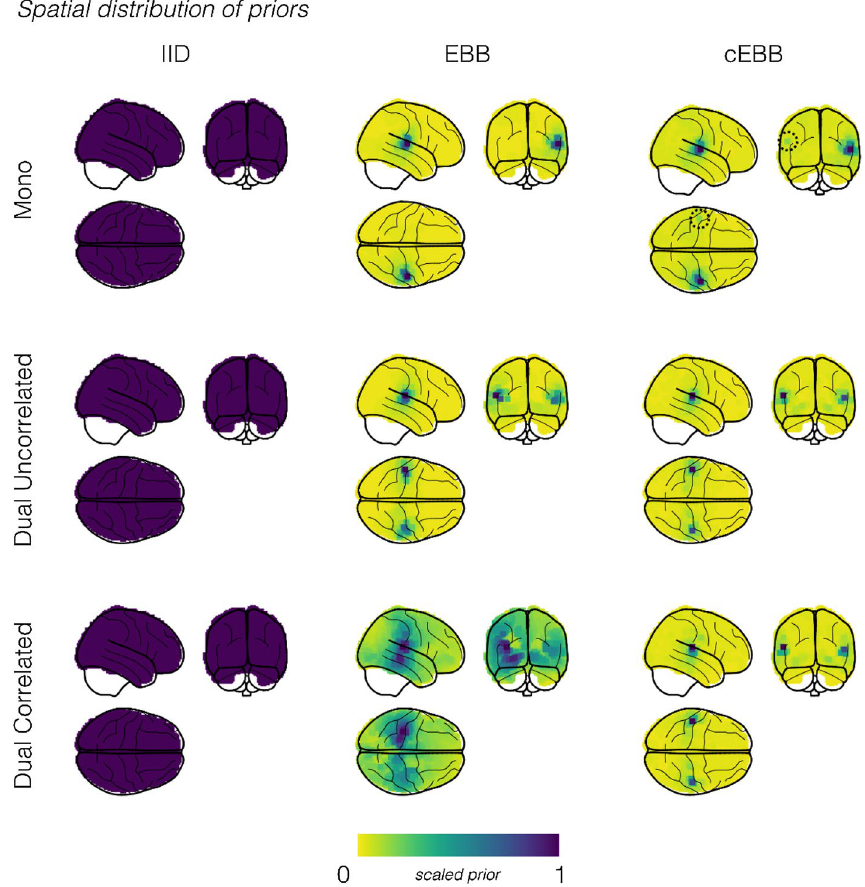
Figure 2. Spatial distributions of the source priors and reconstructed source power plotted onto glass brains for simulations within Heschl’s gyri. Results have been transformed into MNI space. The spatial distribution of the source priors, scaled relative to their maximum value for three inverse models, Minimum Norm Estimation (IID), Empirical Bayesian Beamforming (EBB) and correlated source Empirical Bayesian Beamforming (cEBB). The dashed circle highlights a case where cEBB will estimate variance of a non-existent source in the contralateral hemisphere due to the presence of a genuine source in the ipsilateral